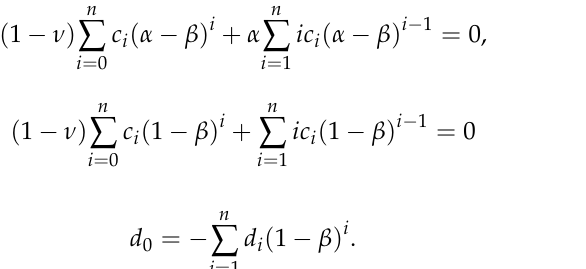
Table 1. The results of numerical calculation of c 0 , c 1 and d 0 .